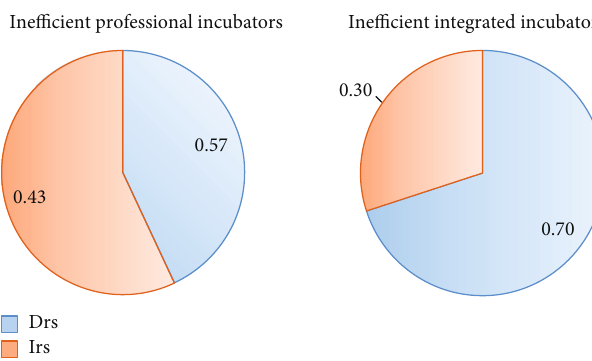
Figure 7: Relationship between ine ffi cient incubators and scale.